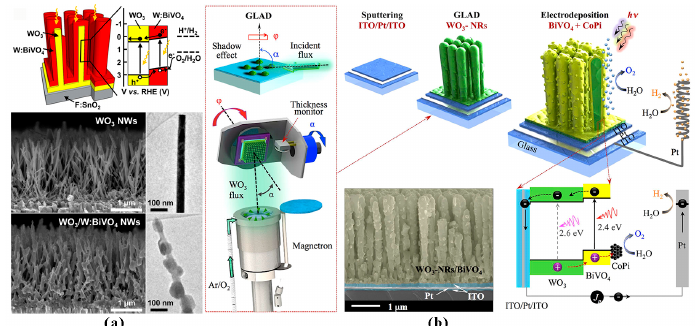
Figure 3. ( a ) WO 3 /BiVO 4 core-shell nanowires (NWs) according to Rao et al. [84] and ( b ) WO 3 /BiVO 4 core-shell nanorods (NRs) by Pihosh et al. [38]. Image ( a ) reprinted with permission from